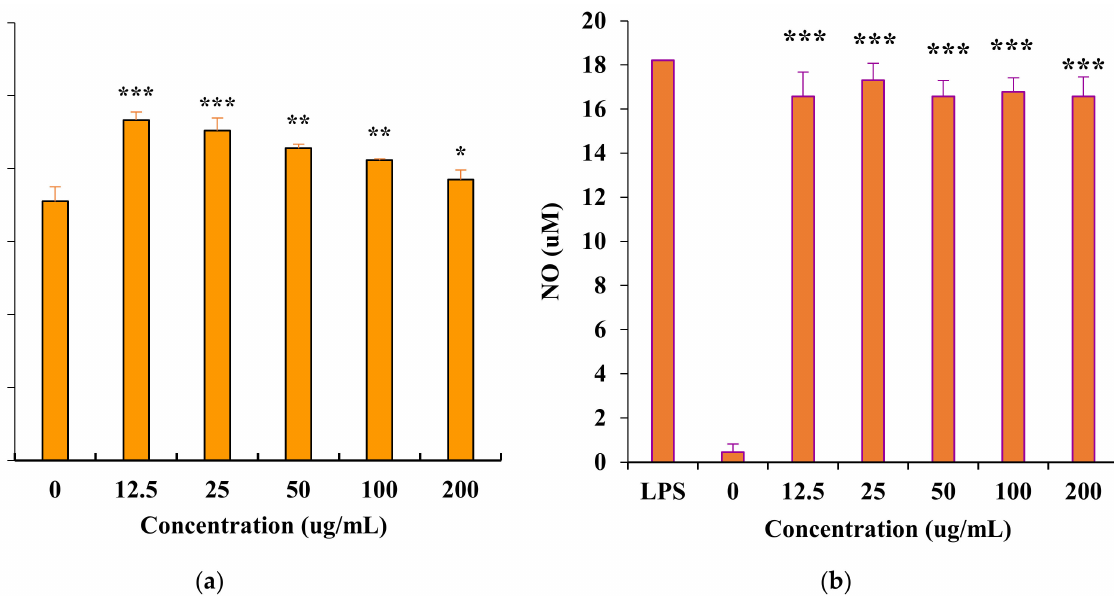
Sepharose 4B column chromatography; Figure S3: Standard curve of Dextrans; Figure S4: The UV spectrum of